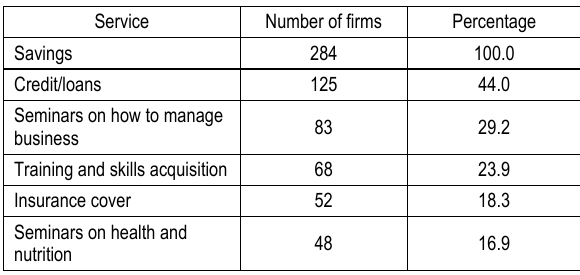
Table1. Services rendered by microfinance banks